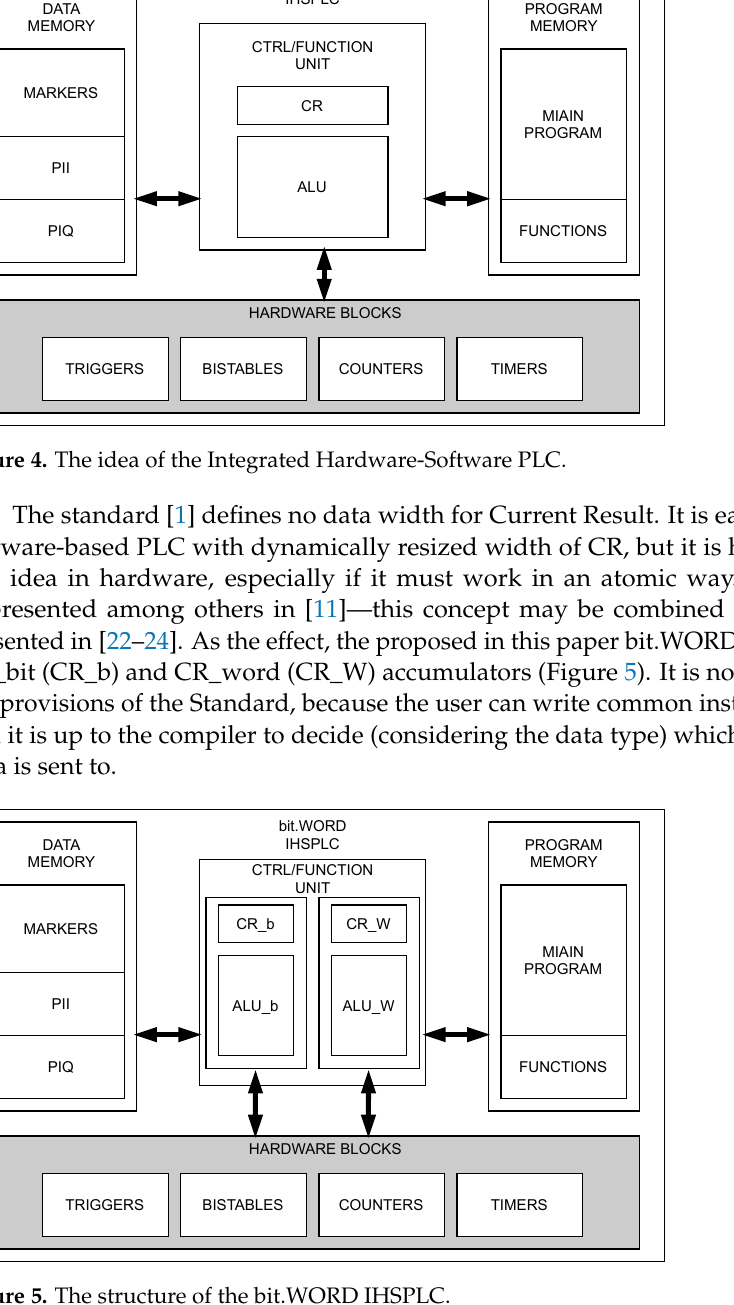
Figure 5. The structure of the bit.WORD